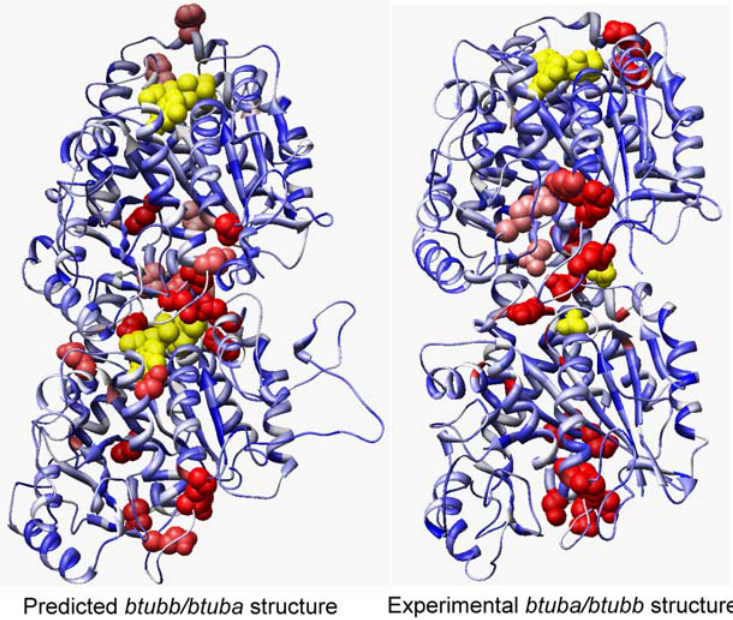
Figure 4. The application of MFS to understand the role of btuba/btubb dimer in the bacterial genus Prosthecobacter using the predicted and experimental structures. Both structures are colored by depicting higher MFS scoring residues with a more intense red color, with the top-10 high-scoring residues represented by spheres. One GTP and one GDP in the predicted structure, as well as one GDP and two SO 42 2 ions in the experimental structure are shown as yellow spheres. The predicted structure is generated by homology-modeling techniques using the eukaryotic a / b tubulin dimer (PDB identifier: 1jff) as the template. The taxol ligand and metal ions are omitted from the predicted structure for easier depiction. In the predicted structure, btubb lies above btuba , with a GDP molecule enclosed by the dimer interface. In the experimental structure (PDB identifier: 2btq), btuba lies above btubb and there is no GDP in the dimer interface. Our MFS analysis first confirmed that btuba and btubb indeed form dimers due to the existence of a high-scoring cluster in their dimer interface, in contrast to previous predictions made by using the structural stability score alone. In addition, the MFS suggests that regardless of how btuba and btubb orient with each other, their interface is functionally important and may bind to GDP